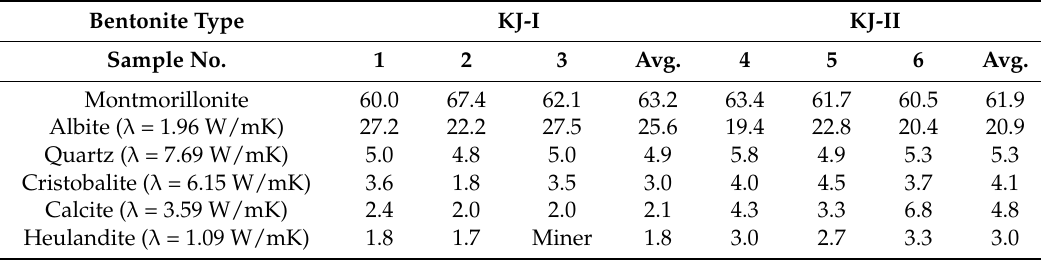
Figure 2. X-ray diffraction pattern of the KJ-I and KJ-II powders. Table 1. Quantitative XRD analysis (wt%) for mineral constituents of KJ-I and KJ-II powders.